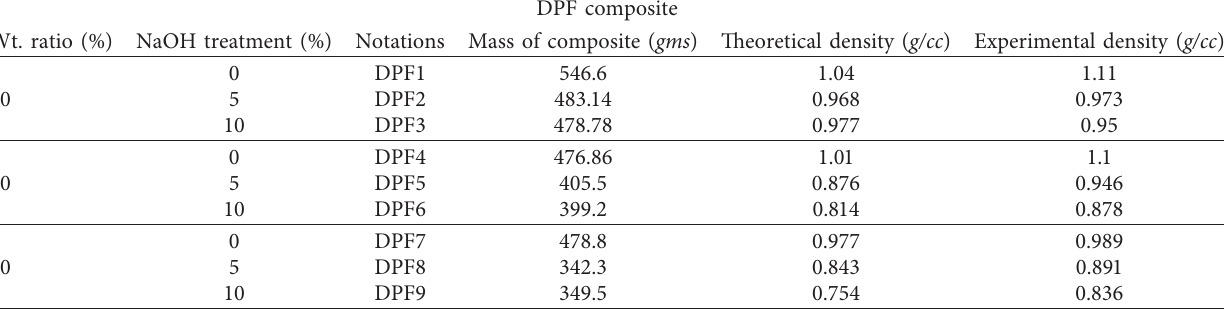
Table 2: Estimated density and mass of DPF fiber reinforced composite using the rule of mixture. DPF composite